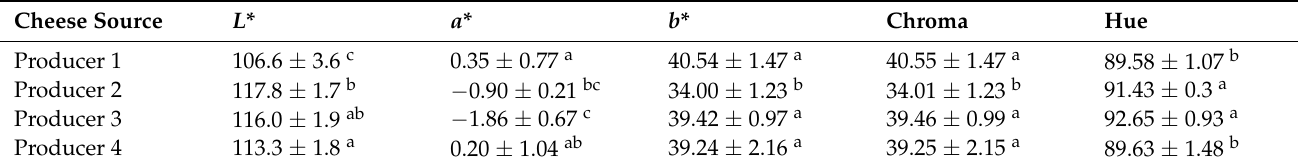
Table 2. Results of color analysis of Queijo de Estrella PDO cheeses.